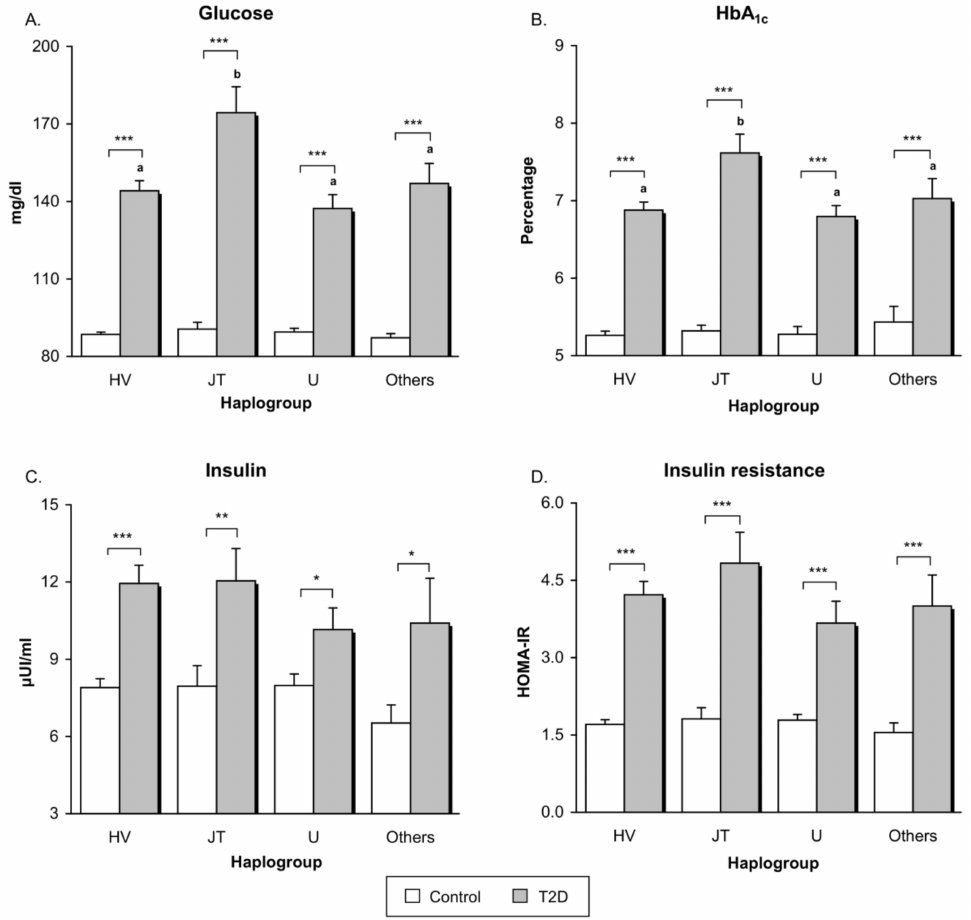
despite adjustments for duration of diabetes ( p = 0.006 for fasting glucose and p = 0.002 for HbA 1c ). Nevertheless, no differences were found in the levels of fasting insulin ( p = 0.50) and HOMA-IR index ( p = 0.38) when T2D patients with different haplogroups were compared (grey bars in Figure 1C,D). Control subjects did not reveal differences depending on haplogroup for any of the parameters related with glycaemic control and insulin resistance (white bars in Figure 1; glucose: p = 0.70; HbA 1c : p = 0.81; insulin: p = 0.60; HOMA-IR: p = 0.83).